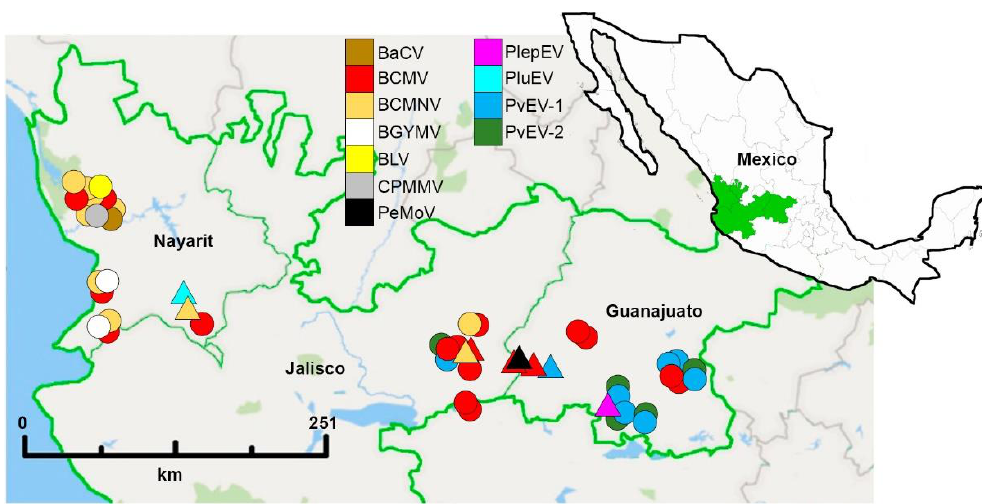
Figure 2. Virus distribution infecting Phaseolus spp. in the Mesoamerican center of domestication of common bean (Jalisco and Guanajuato States) and Nayarit, Mexico. The colors indicate the corresponding viral species. Circles and triangles correspond to the viruses identified in domesticated and wild Phaseolus spp., respectively. Geographic coordinates are indicated in Table S1.